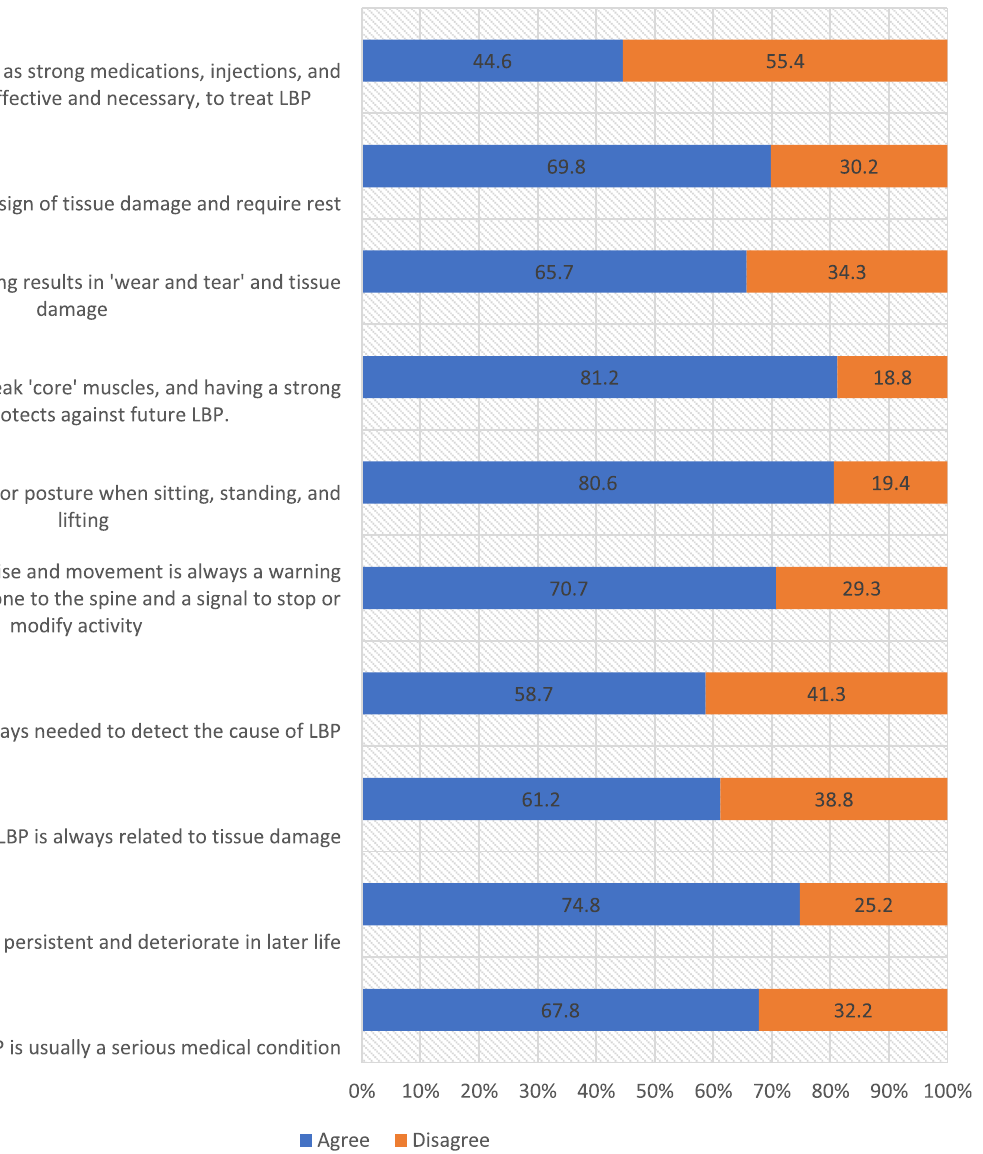
Fig. 2 Graphical representation of frequencies (%) of individuals responding as agreeing or disagreeing for the belief ’ s statements associated with